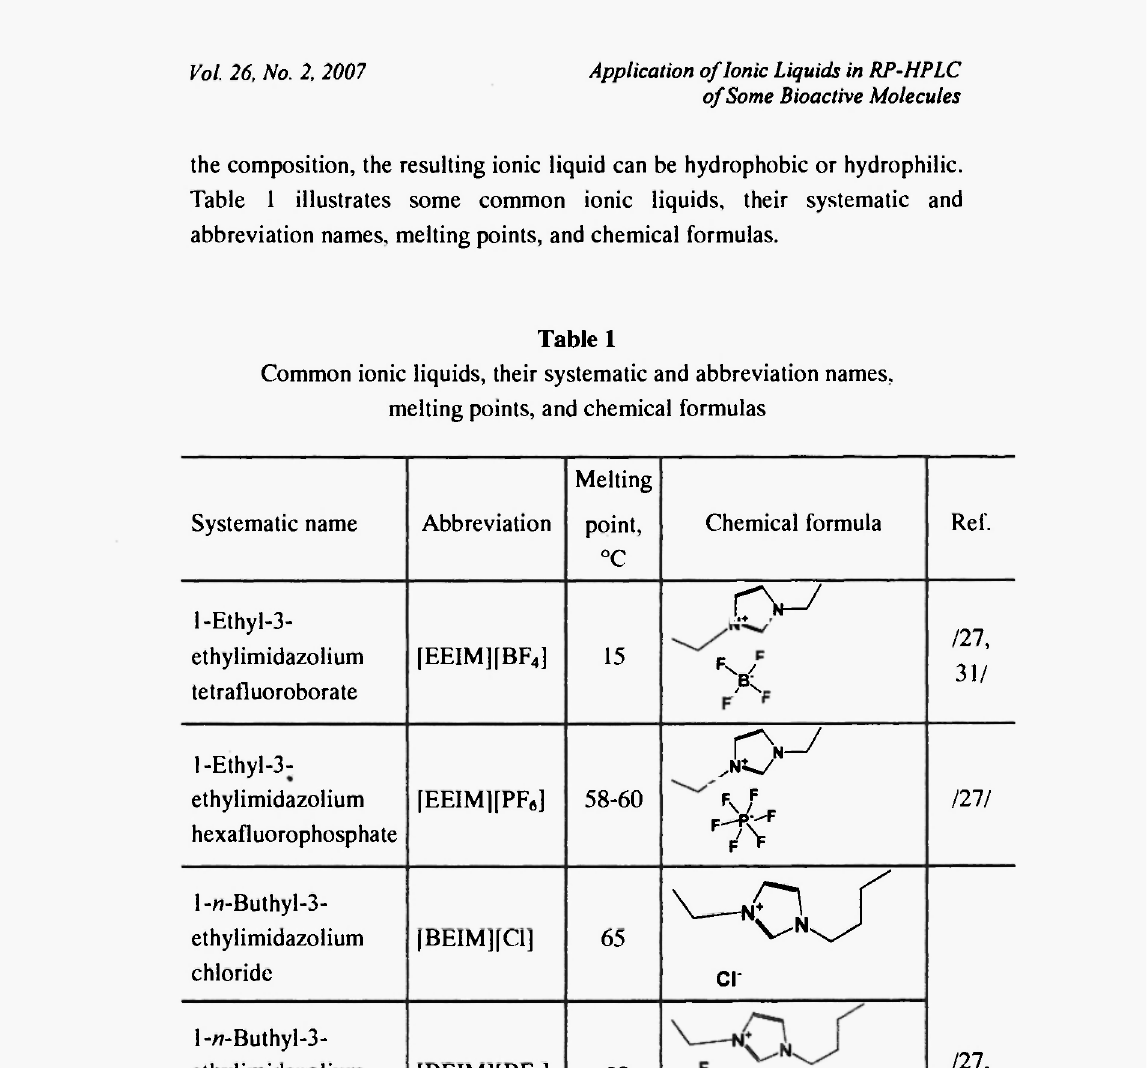
1 illustrates some common ionic liquids, their systematic and